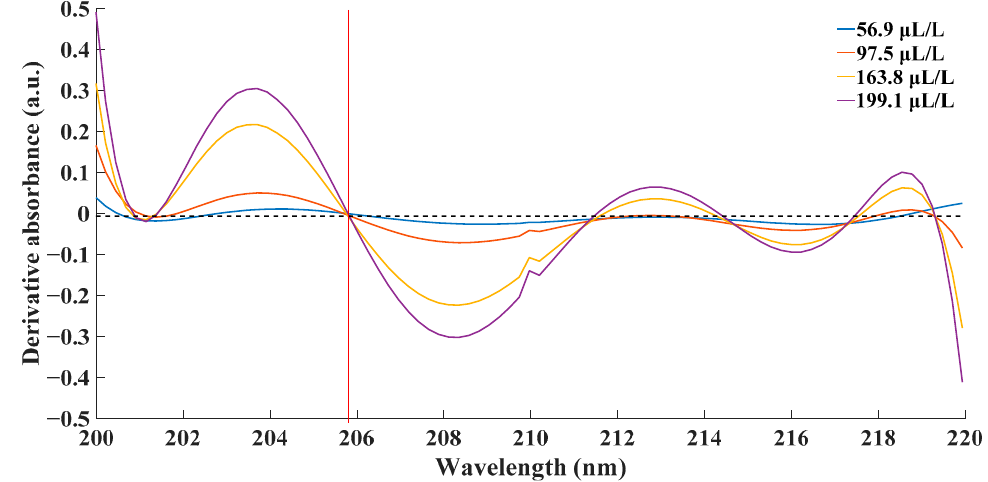
Figure 6. Derivative spectra of absorbance at different concentration of SO 2.